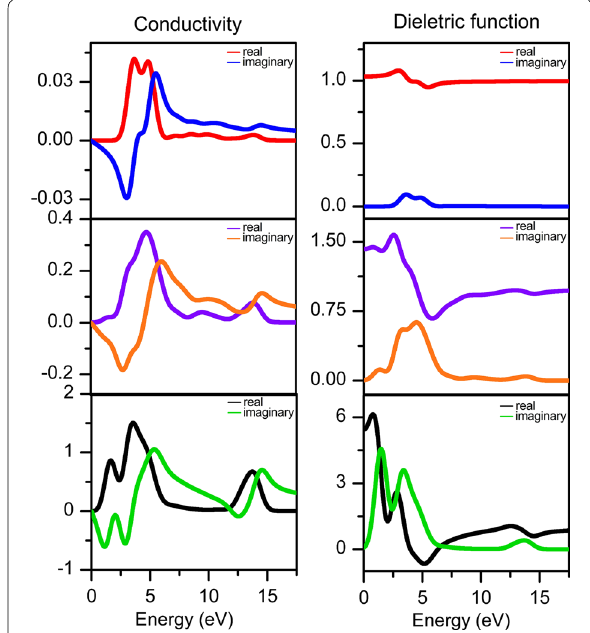
Fig. 5 Real and imaginary parts of conductivity and dielectric func‑ tions spectra of perylene molecule (1st row), DIP molecule (2nd row) and DIP crystal (3rd